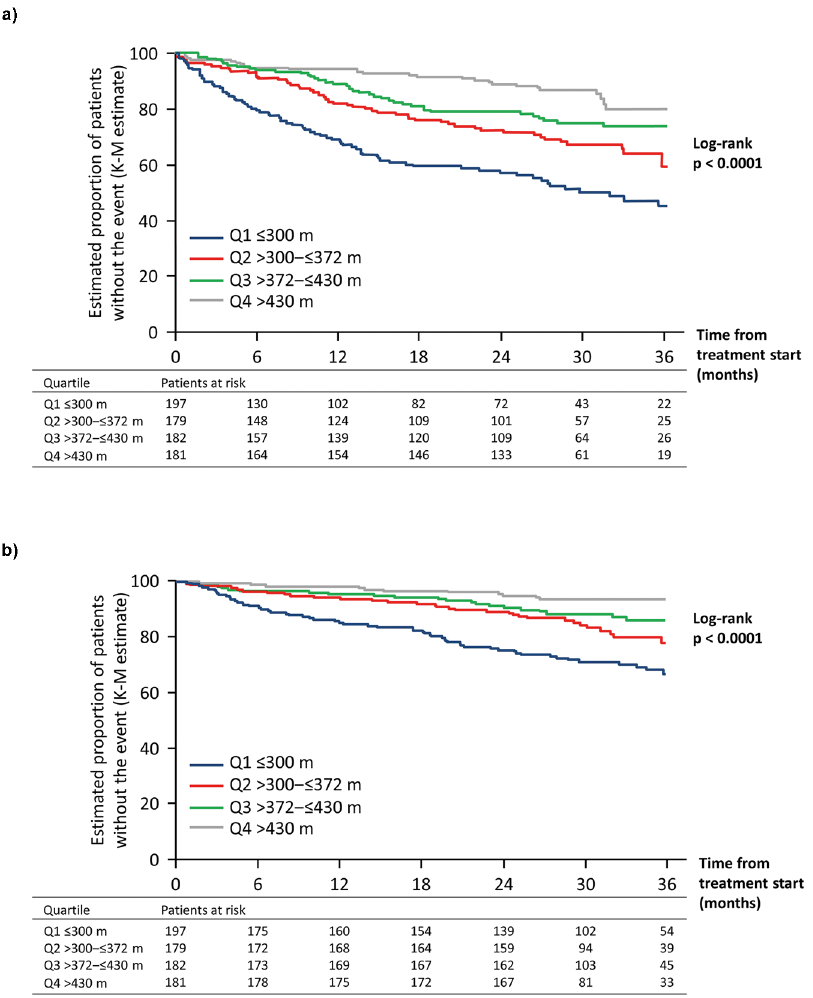
Fig 3. Association between absolute 6MWD quartiles at baseline and long-term outcomes in patients with PAH: A. PAH-related death or hospitalization up to end of treatment; B. All-cause death up to end of study. 6MWD, six-minute walk distance; K-M, Kaplan–Meier; PAH, pulmonary arterial hypertension.